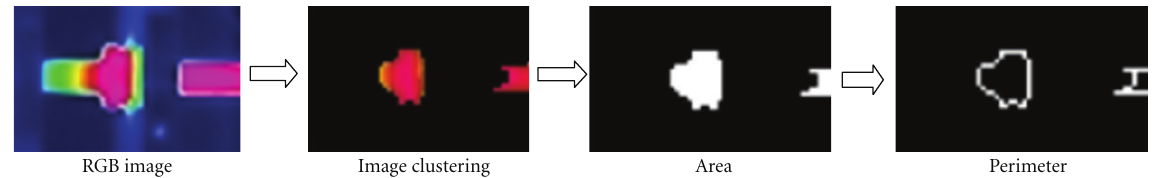
Figure 10: Processing of bearing thermal